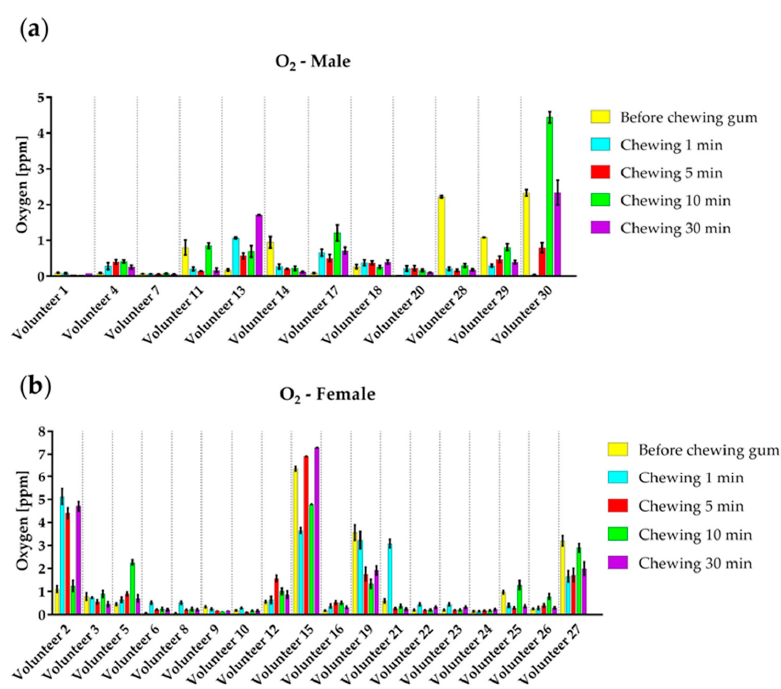
Figure 4. Results of O 2 measurements for each volunteer ( a ) male, ( b ) female.